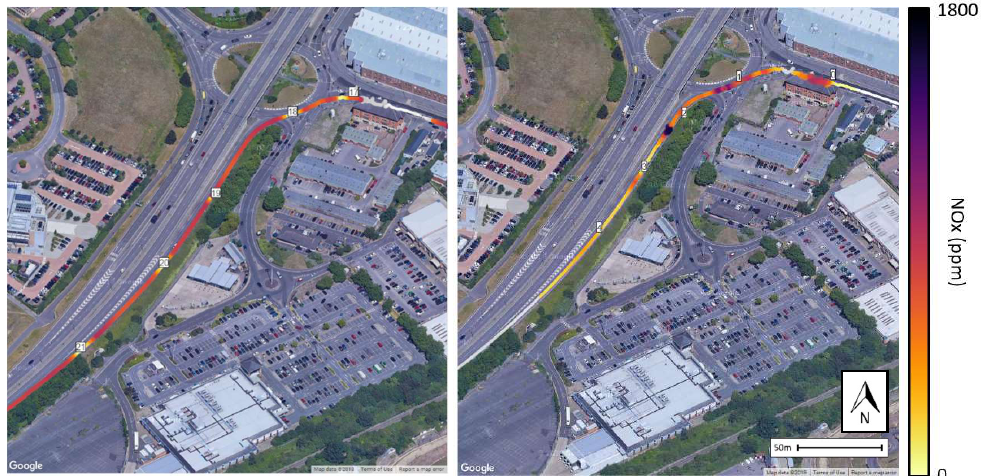
Figure 16. NO x emissions from the Euro V (L) and Euro VI (R) buses at the start of journey—showing